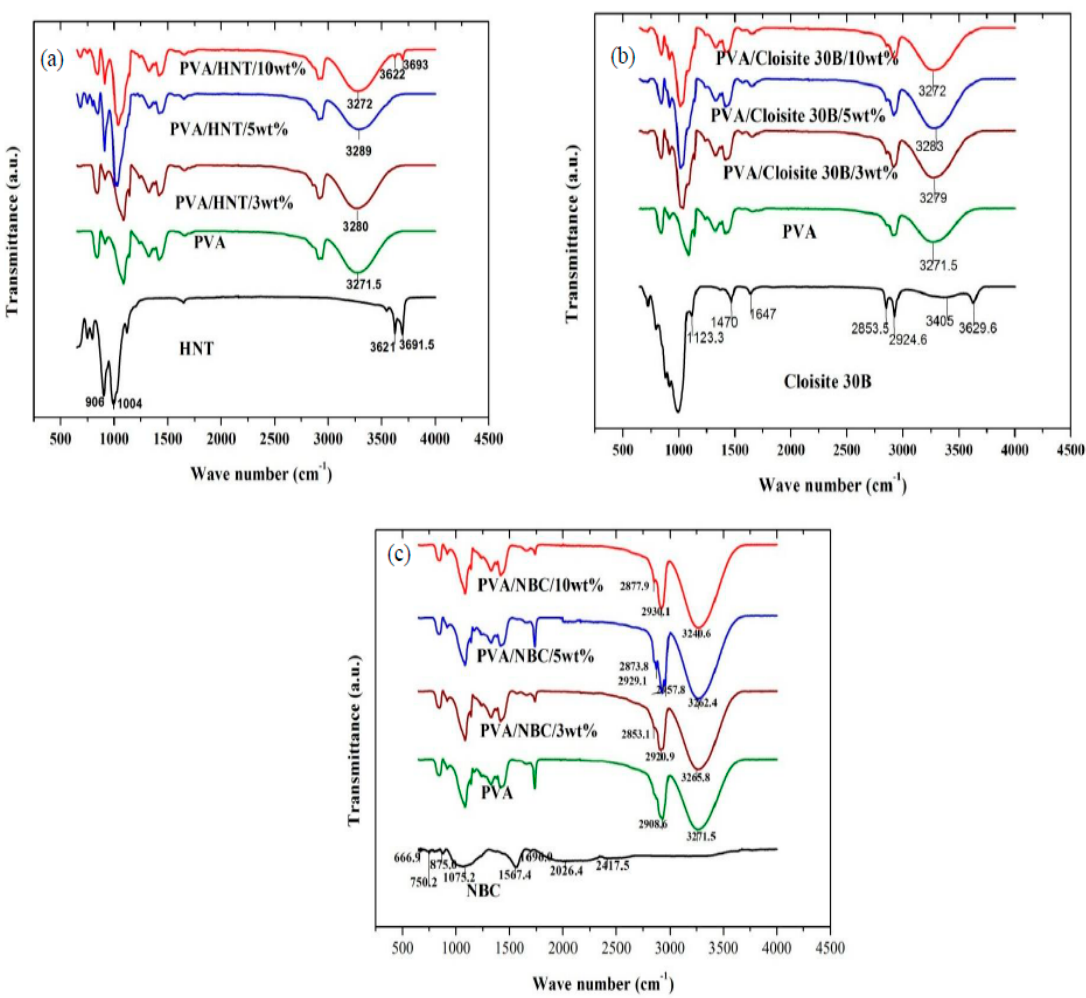
Figure 2. FTIR spectra for chemical interactions of polyvinyl alcohol (PVA) bionanocomposite films reinforced with ( a ) HNTs, ( b ) Cloisite 30B clays, and ( c ) NBCs.